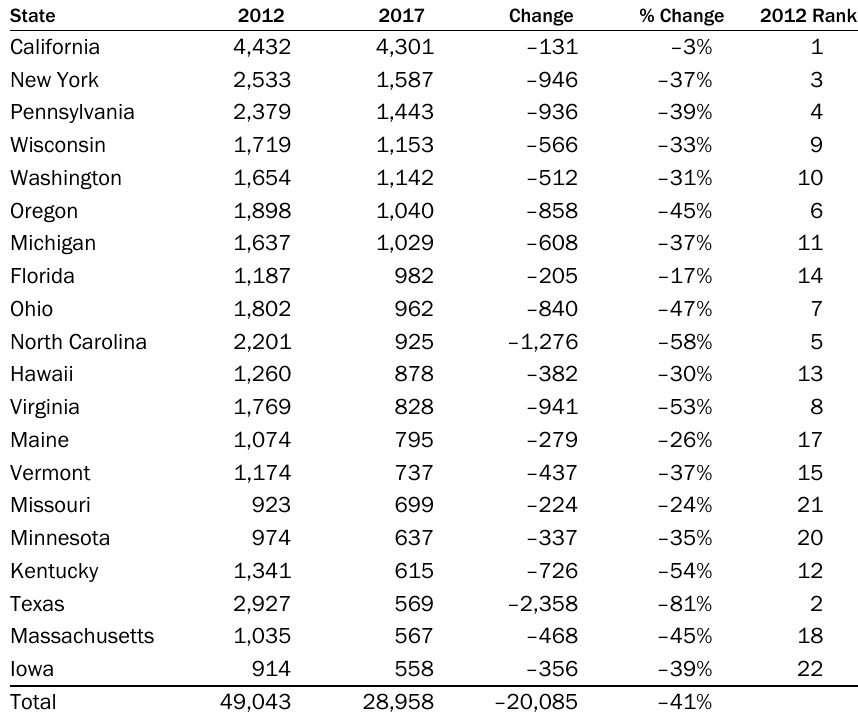
Table 4. Change in Number of Direct Wholesale Farms, 2012 to 2017, for the 20 States with the Highest Number of Direct Wholesale Farms in 2012